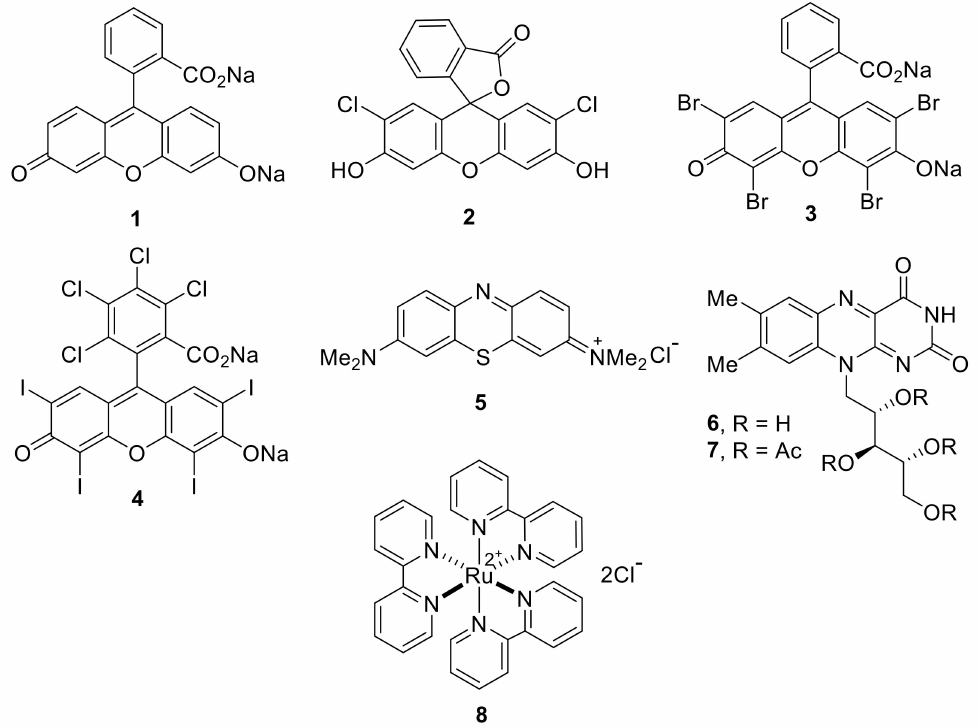
Figure 1. Photocatalysts employed in this